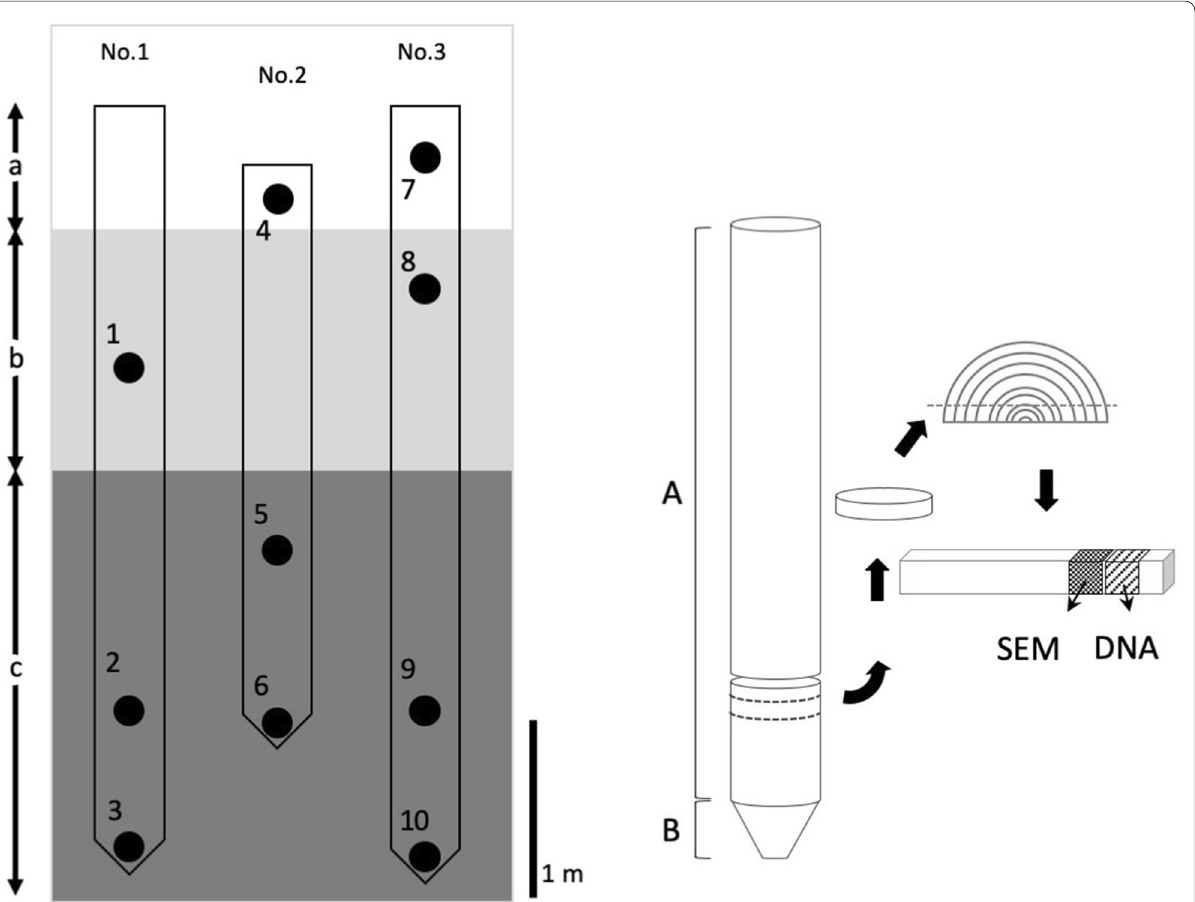
Fig. 2 A diagram of the investigated logs. Left panel shows sectioning of the logs: (a) the aerial section, (b) the aqueous section, (c) the underground section and the pencil-shaped bottom tip. The numbers on the logs indicate the sampling sites. Right panel shows an overview of the log: (A) log with bark, (B) pencil-shaped bottom part (approximately 30 cm